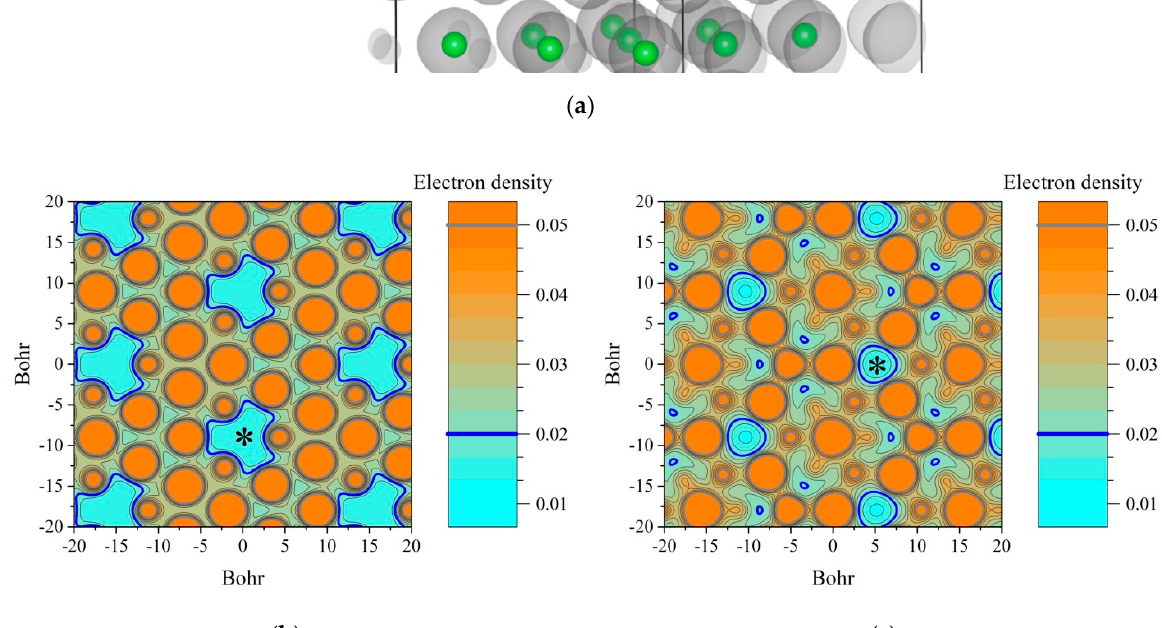
Figure 11. Electron density distribution in the interface vicinity of Zr 63 Nb 40 slab ( a ) and in the first Zr ( b ) and Nb ( c ) atomic layers. The blue and gray isosurfaces in panel ( a ) correspond to a charge density of 0.02 and 0.05 electrons/Bohr 3 , respectively. The areas of a reduced electron density in the Zr ( b ) and Nb ( c ) atomic layers are marked with (*). Color gradation scale in the ( b , c ) panels is given in electrons/Bohr 3